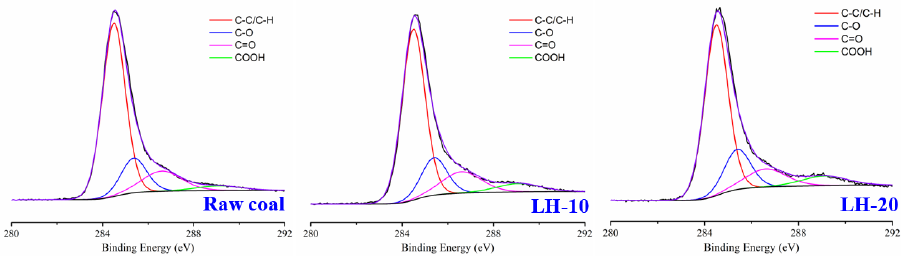
Figure 8. Peak fitting of the XPS C1s peak.